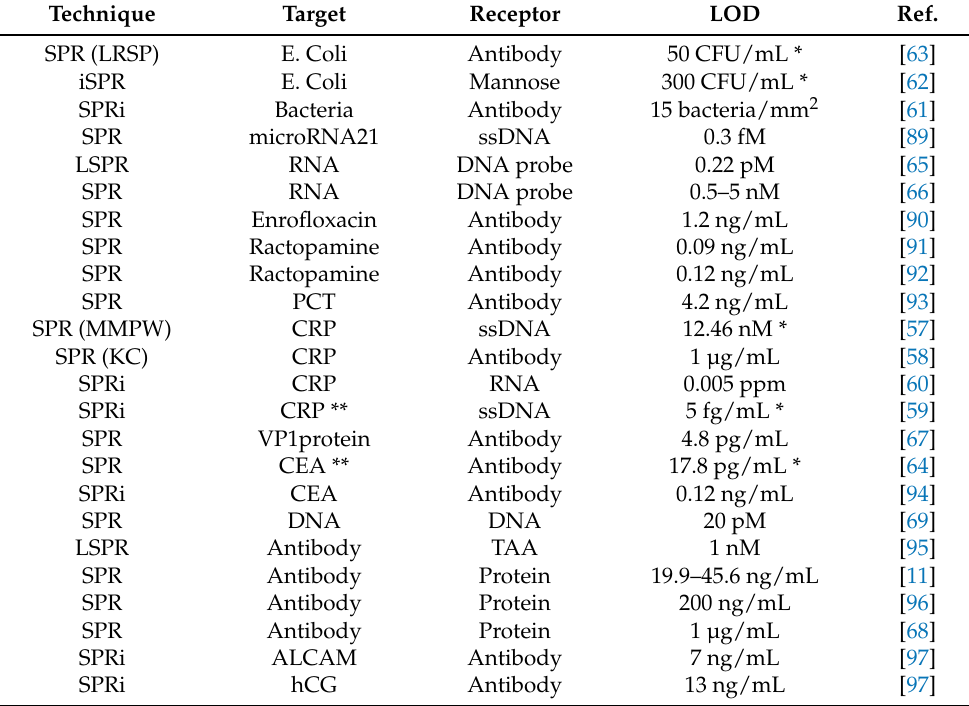
Table 1. Overview of different analytes detected with SPR technology (SPRi = SPR imaging, MMPW = multi-mode polymer waveguide, LRSP = long-range surface plasmon, iSPR = interdigitated